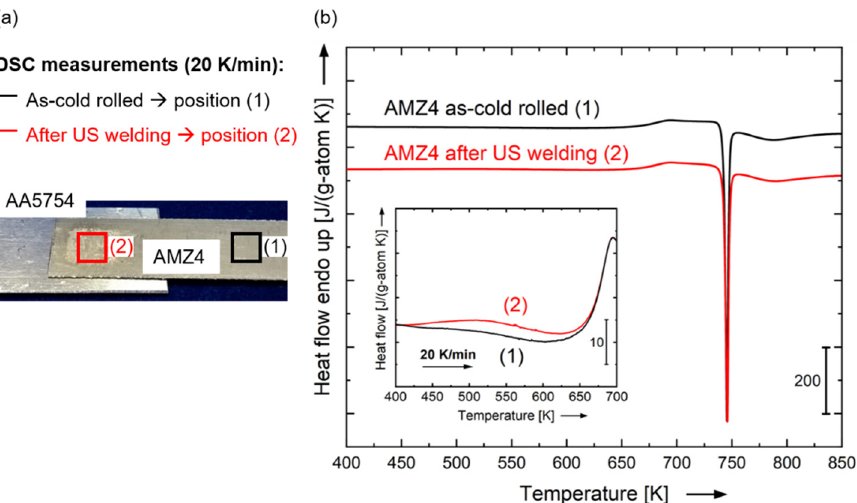
Figure 9. Differential scanning calorimetry study of AMZ4 before and after ultrasonic welding. ( a ) Photograph of the welded sample showing the positions from which the samples for the calorimetry are cut, where (1) indicates AMZ4 material far away from the joint, which represents AMZ4 in the as-rolled state, and (2) the AMZ4 part subjected to ultrasonic (US) welding. ( b ) Subtracted heat flow scans for the as-rolled AMZ4 (1) and AMZ4 after US welding (2). Δ H x is the heat of crystallization associated with the area of the first exothermic peak, which is obtained by integrating the peak. The inset shows the magnified heat flow signals in the low-temperature regime just before the sharp increase at the glass transition. The welded sample shows a smaller (less negative) heat release due to relaxation than the as-rolled sample, because it already encountered some degree of relaxation during the welding process.